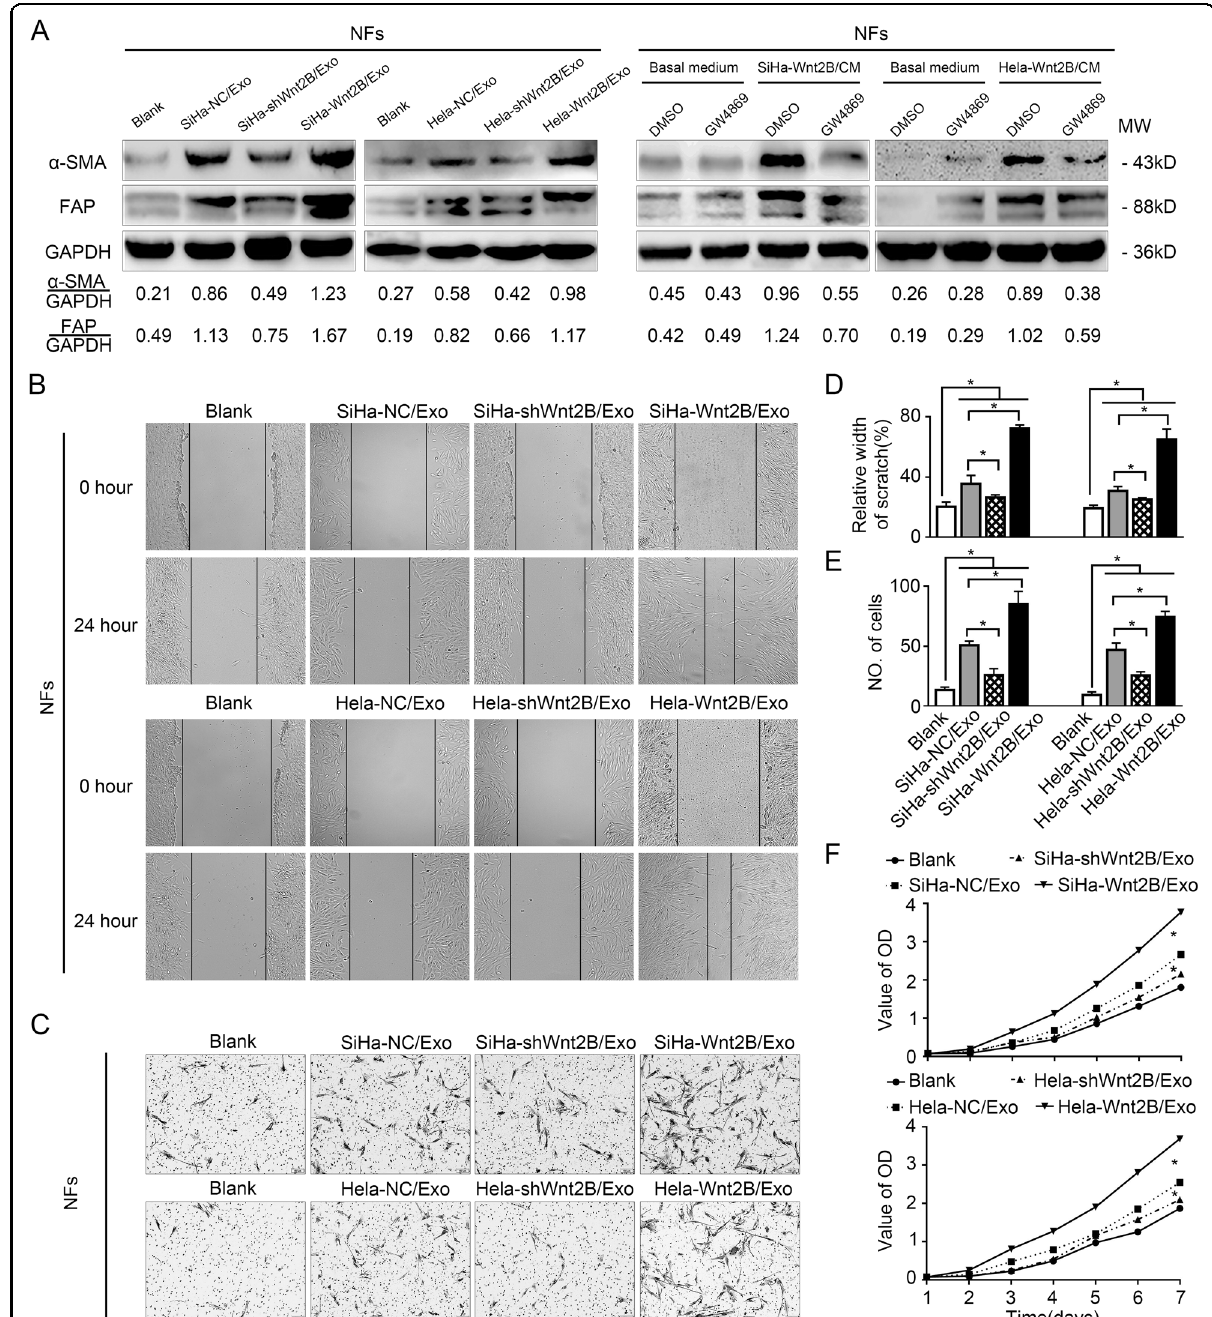
Fig. 4 Exosomal Wnt2B promotes fi broblast activation. A Western blot analysis for α -SMA and FAP expression in NFs cultured alone (blank group) or co-cultured with the indicated exosomes (left). Western blot analysis for α -SMA and FAP expression in NFs pre-treated with CM from SiHa-Wnt2B and Hela-Wnt2B cells treated with DMSO or GW4869, while NFs treated with DMSO or GW4869 in the basal medium were used as the control group (right). B Wound healing assay using treated fi broblasts. C Migration assay using treated fi broblasts. D Cell migration quanti fi ed as a percentage of the wound-healed area. E Average number of invading cells per fi eld from three independent experiments. F Proliferation assay using treated fi broblasts. Error bars represent the mean ± SD of three independent experiments. * P < 0.05.